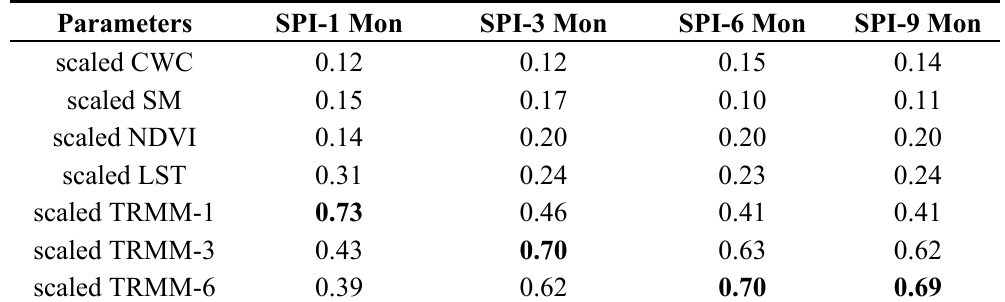
Table 3. The correlation coefficient (R) between the scaled remote sensing parameters and the in situ SPI at multiple timescales (1, 3, 6 and 9 month). TRMM-1, TRMM-3, and TRMM-6 represent the monthly, three-month, and six-month TRMM precipitation data.